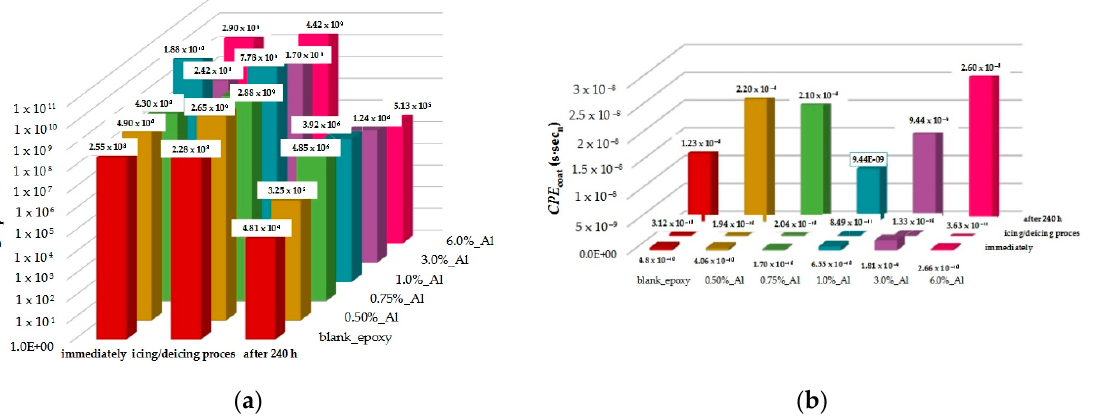
Figure 10 . Overview of ( a ) coating resistance (R p ) and ( b ) constant phase element (CPE coat ) for epoxy matrix without Al NP, and prepared nanocomposites with 0.50%, 0.75%, 1.0%, 3.0%, and 6.0% Al NP, immediately and after 240 h exposure in aggressive medium (3.5% NaCl), and after testing in climatic chamber.